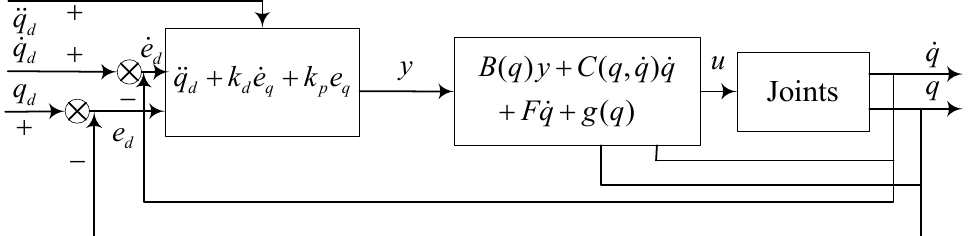
Figure 2. Schematic diagram of inverse dynamics control [21].